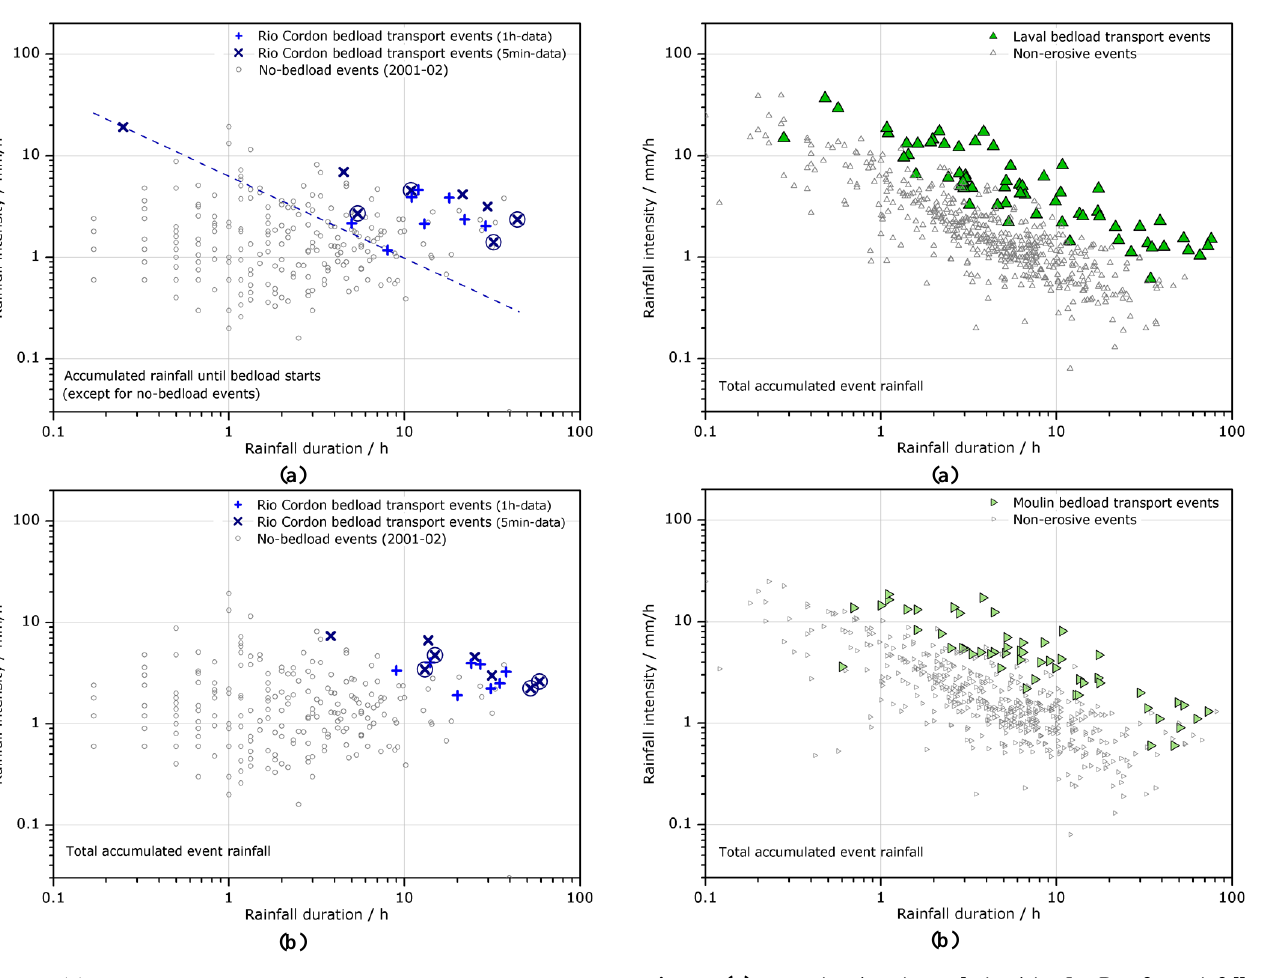
Fig. 4. (a) Intensity–duration relationship I BLS – D BLS for rainfall (recorded until beginning of bedload) that triggered bedload trans- port in the Rio Cordon catchment for the entire study period (cf. Ta- ble 3). The threshold line is manually fitted; (b) Intensity–duration relationship I T – D T for rainfall (recorded for the entire event) that triggered bedload transport in the Rio Cordon catchment. Rainfall events not leading to bedload transport (for the years 2001 to 2002 only) are marked by grey circles in (a) and (b) . The four large blue circles indicate which rainfall events with bedload transport occurred during these two years.